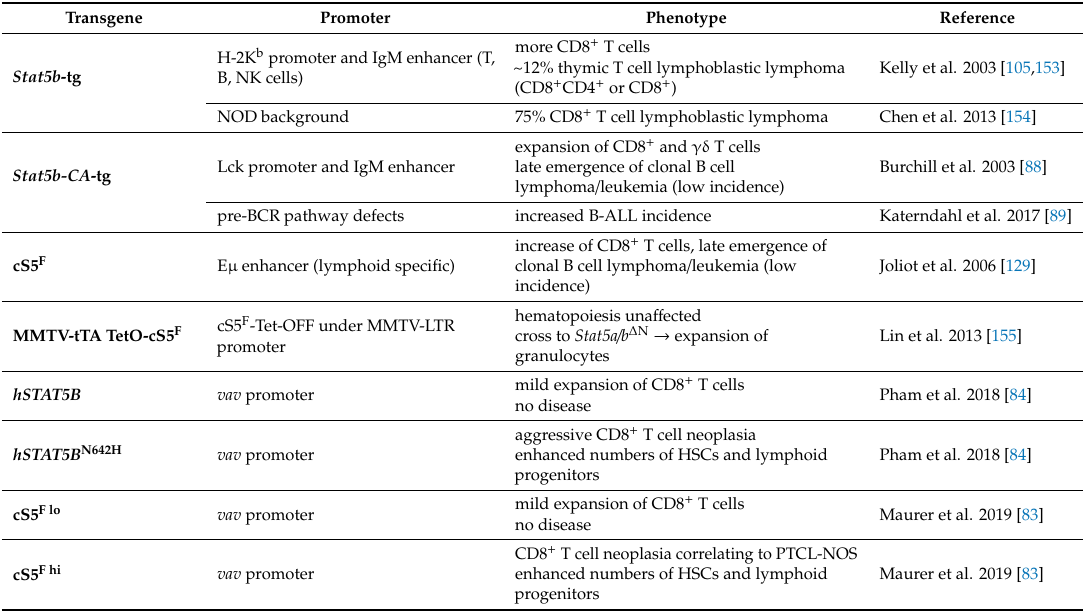
Table 2. Hematopoietic STAT5A / B transgenic mouse